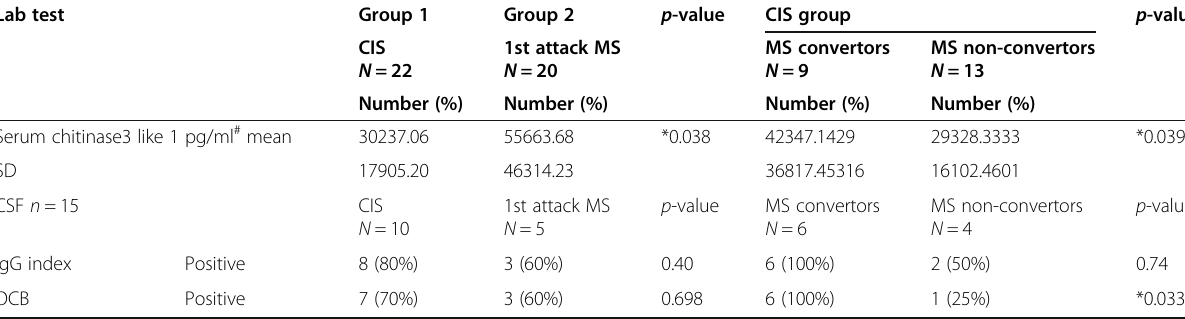
Table 2 Laboratory results of the studied groups Lab